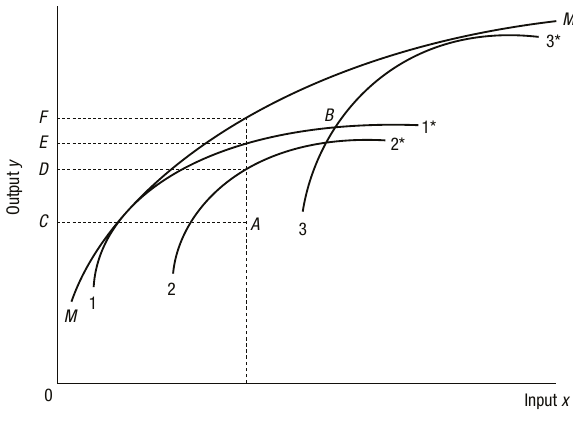
Fig. 1. Group specific frontier and